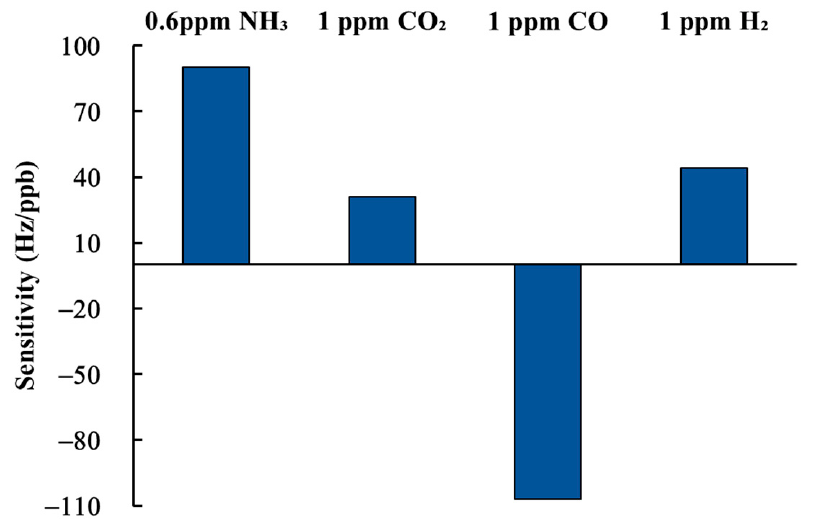
Figure 10. Sensitivity of a SAW sensor to 0.6 ppm NH 3 gas, 1 ppm CO 2 gas, 1 ppm CO gas, and 1 ppm H 2 gas.